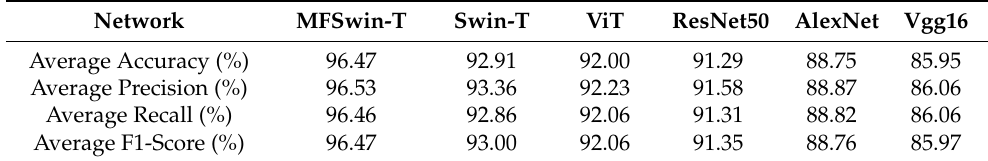
Table 8. Classification and comparison results of different networks.